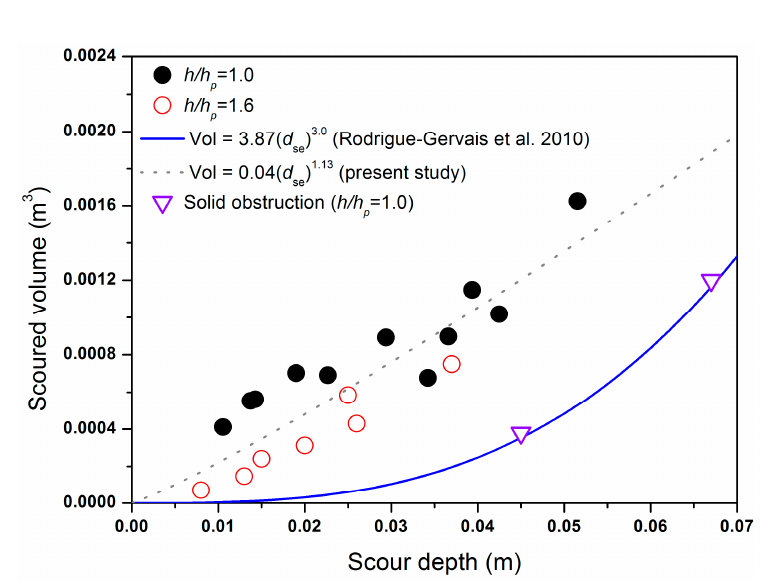
Figure 7. Scoured volume around the porous obstructions with scour depth.